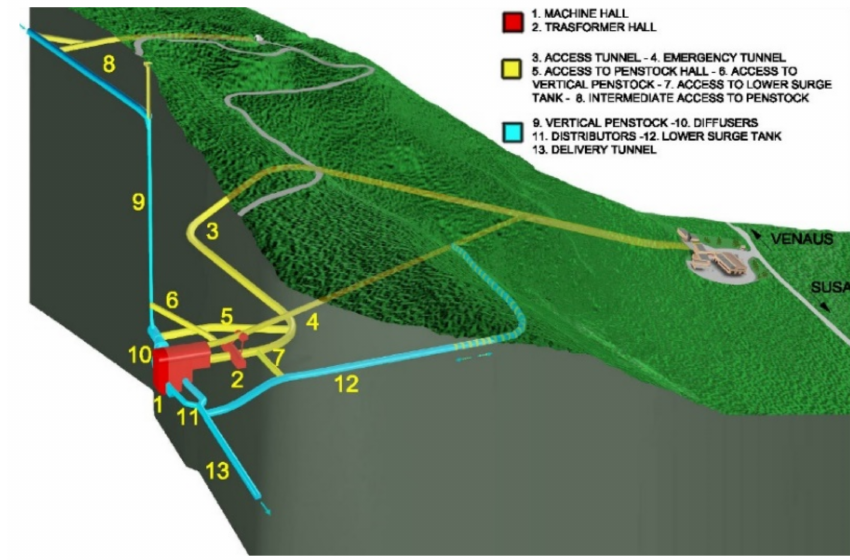
Figure 1. Illustration of the hydroelectric scheme of concern.